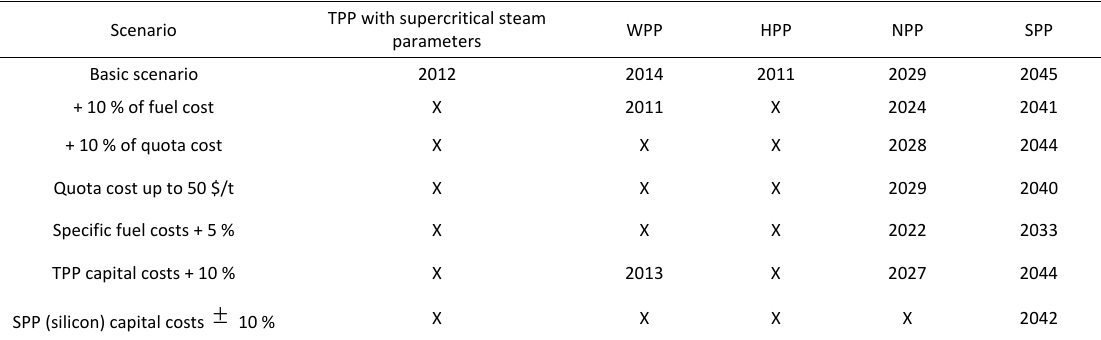
Table 3: Results of scenario modeling for the motion of bifurcation points